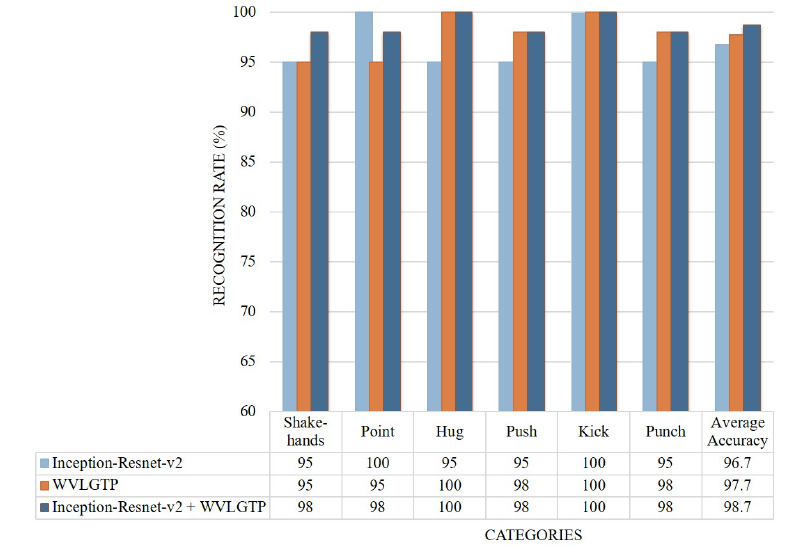
Figure 12. Accuracy comparison of each class by Inception-Resnet-v2, WVLGTP, and Inception-Resnet-v2 plus WVLGTP on the UT interaction dataset.